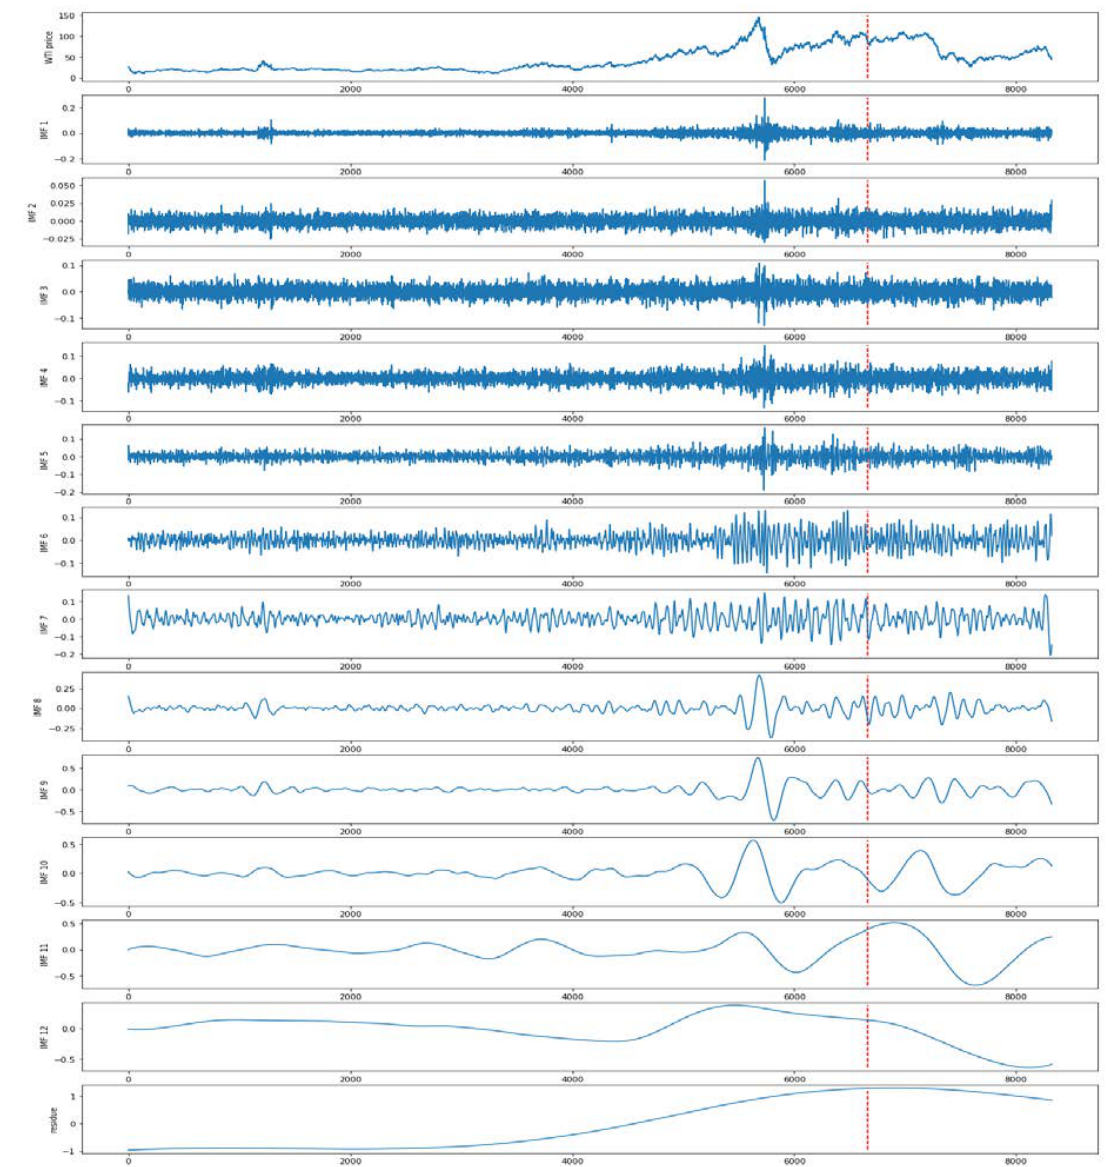
Figure 8. The time–frequency spectrums of IMFs obtained by CEEMDAN. The top sub-picture shows the original WTI price data. The next 12 images represent intrinsic mode functions (IMF), which is listed in the order from the high to the low frequencies. The last component is the residue, which represents the portion of the original data not decomposed and the real trend of the original data.